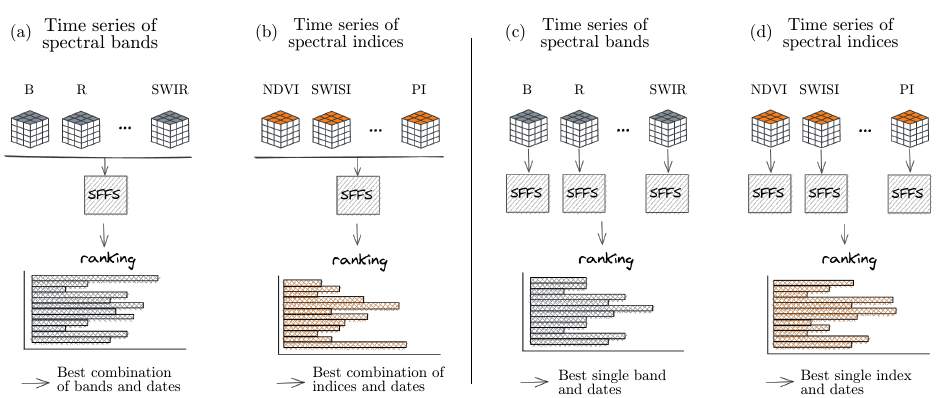
Figure 2. Single and multi-feature SFFS configurations to measure the subsets of spectral features that are the most relevant for mapping poplar stands